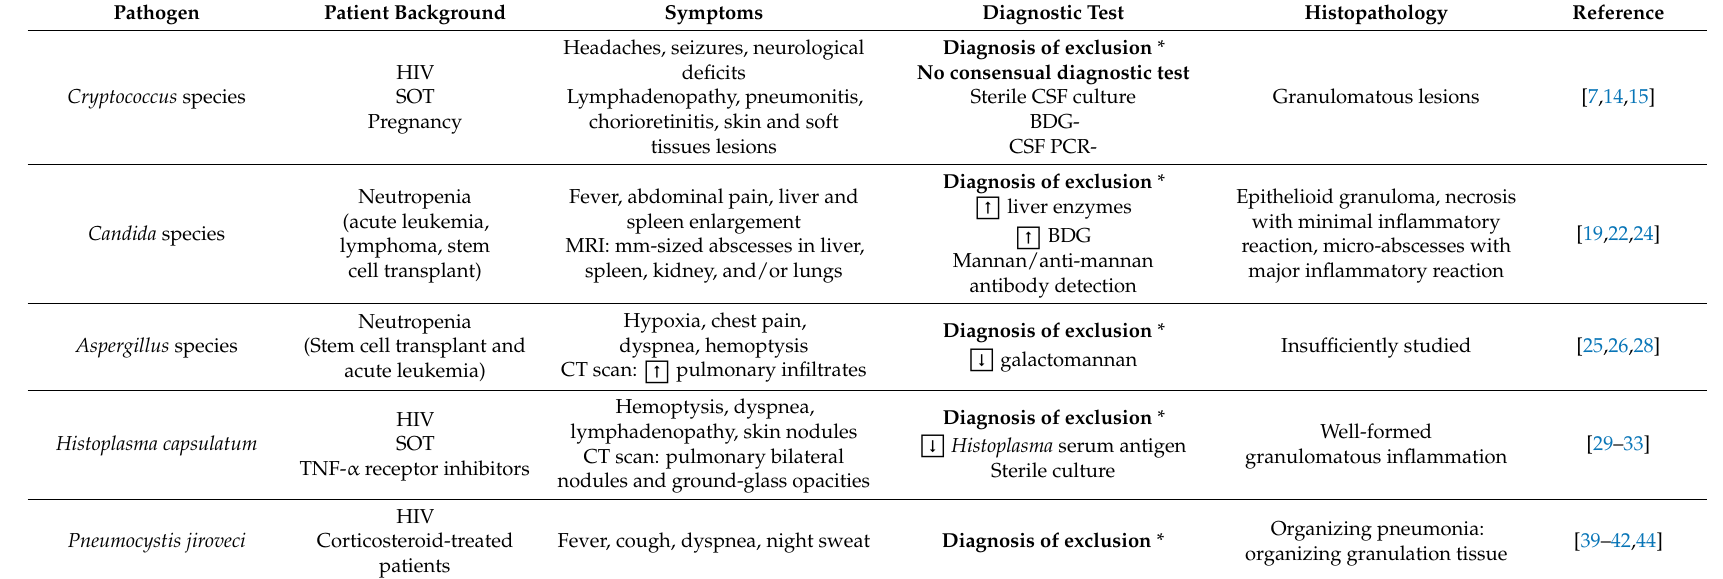
Table 1. Clinical presentation and characteristics of fungi-associated immune reconstitution inflammatory syndrome (IRIS) by fungal species.